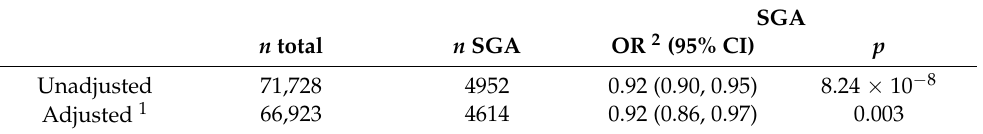
Multiple logistic regression of standardized maternal dietary selenium intake in relation to small for gestational age according to population-based growth curve. 1 Adjusted for maternal age at delivery, maternal